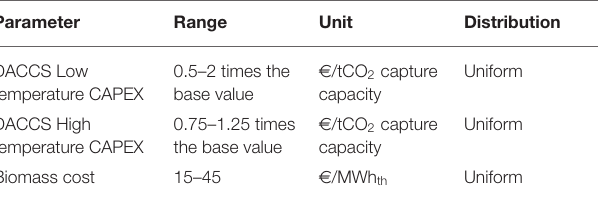
TABLE 1 | Parameters varied in Monte Carlo